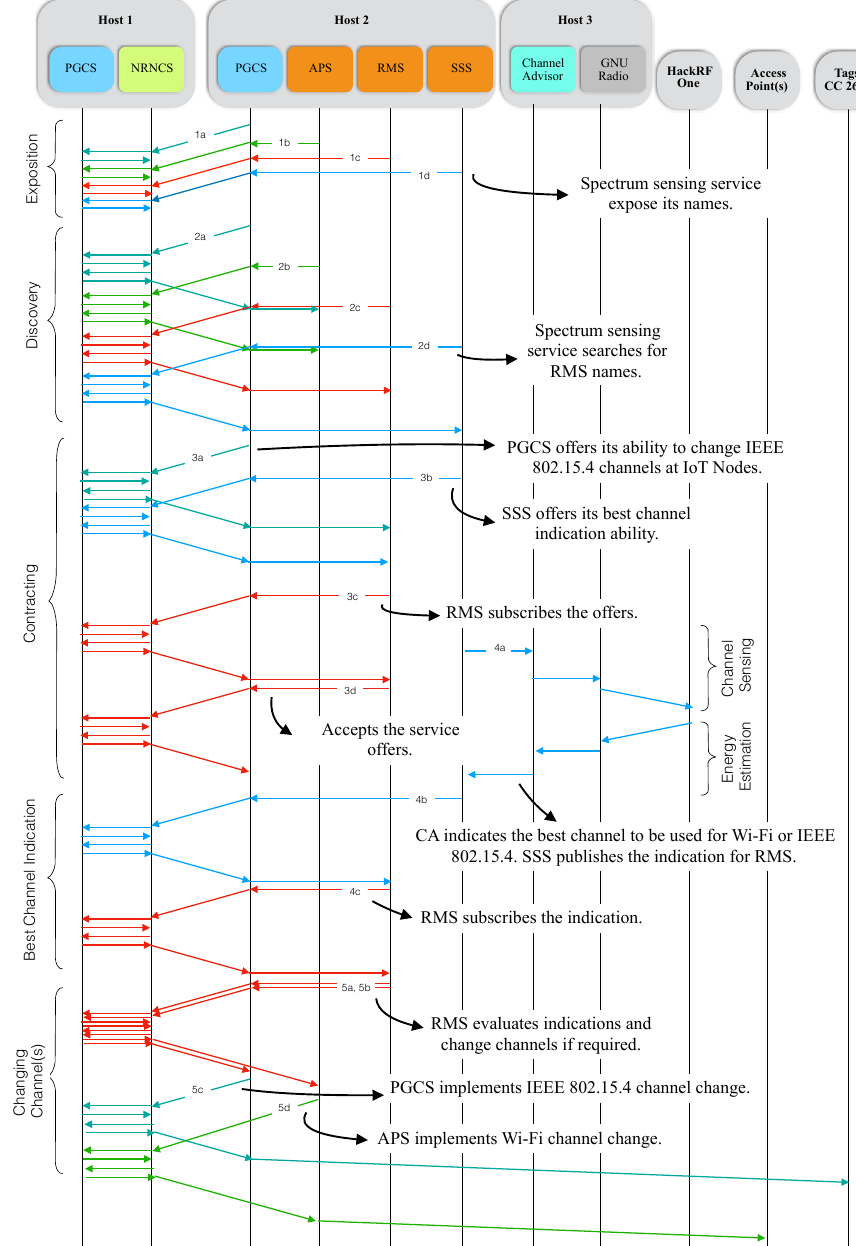
Figure 8. Life-cycle of the dynamic spectrum management approach with NovaGenesis. Five steps are shown: service exposition, service discovery, contracting (dynamic composition), best channel indication and channel changing (Wi-Fi and IEEE 802.15.4). Each vertical line represents the control plane actions related to a certain component. Control actions (Transactions) are named as nc , in which n is related to the life cycle step being performed and c is a sequence number introduced to facilitate understanding. For instance, 1 a is a control plane message send by PGCS to